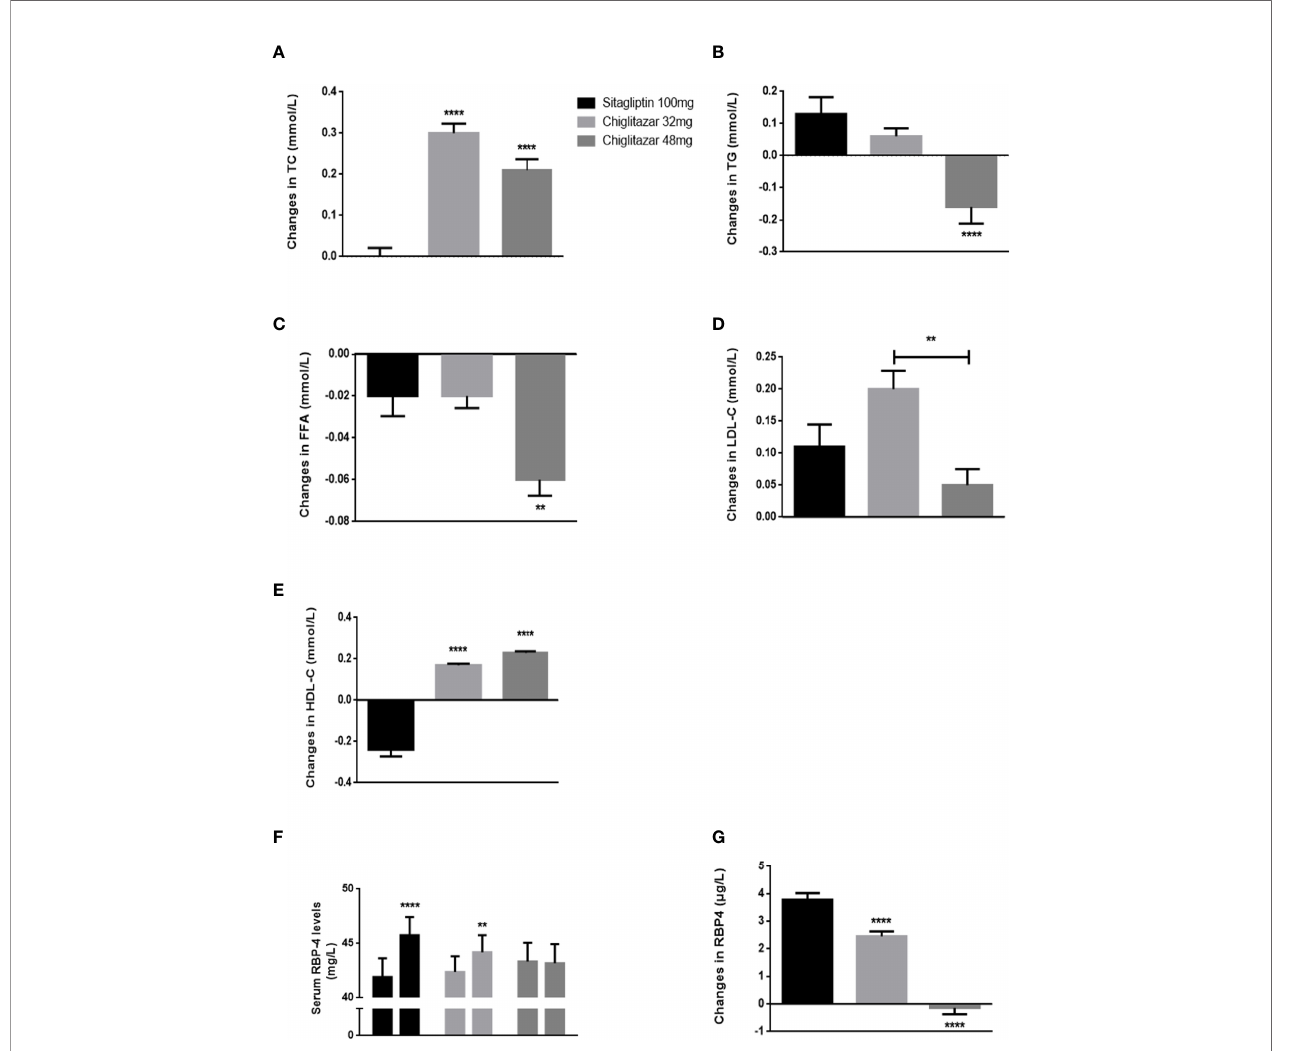
FIGURE 3 | Changes of lipid metabolism parameters and serum RBP-4 levels in groups. (A – E) changes of TG, FFA, TC, LDL-C, and HDL-C shown from baseline to week 24. (F) mean RBP-4 levels of groups from baseline to week 24. (G) changes of RBP-4 levels shown from baseline to week 24. **P < 0.01, ****P < 0.0001. Error bars show standard error of the mean